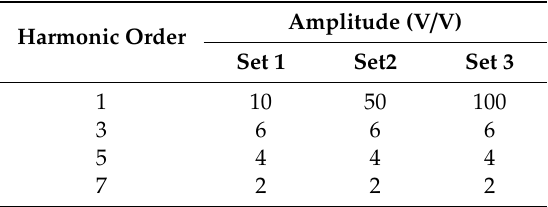
Table 3. The parameters of the input